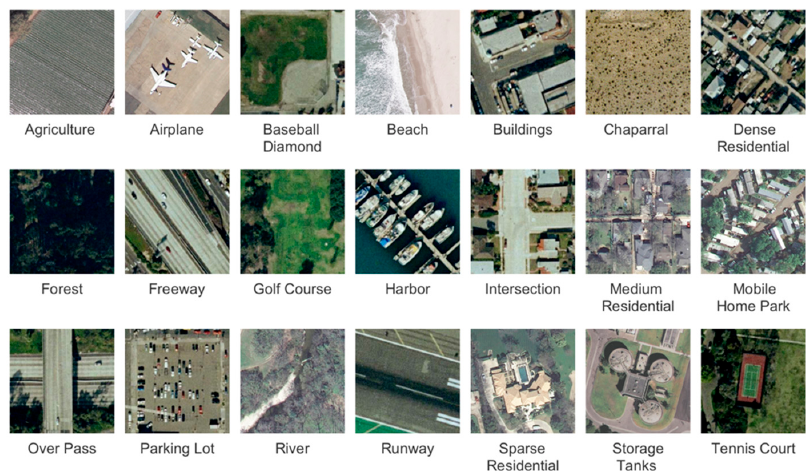
Figure 4. Illustration of the UCMD (UC Merced Land Use Dataset). The UCMD database covers 21 land-cover classes and one image of each class randomly selected from the UCMD are shown.